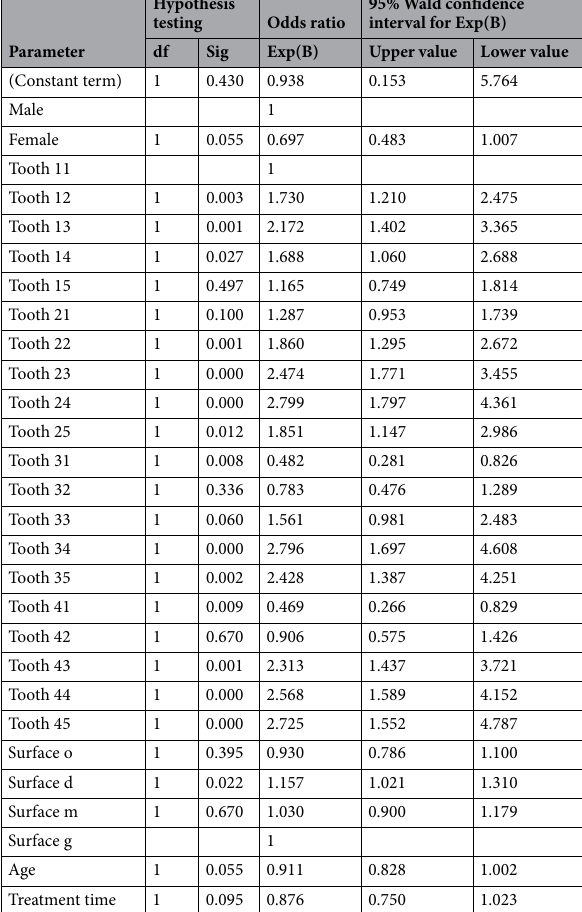
Table 5. Overview of the parameters for the logistic regression: